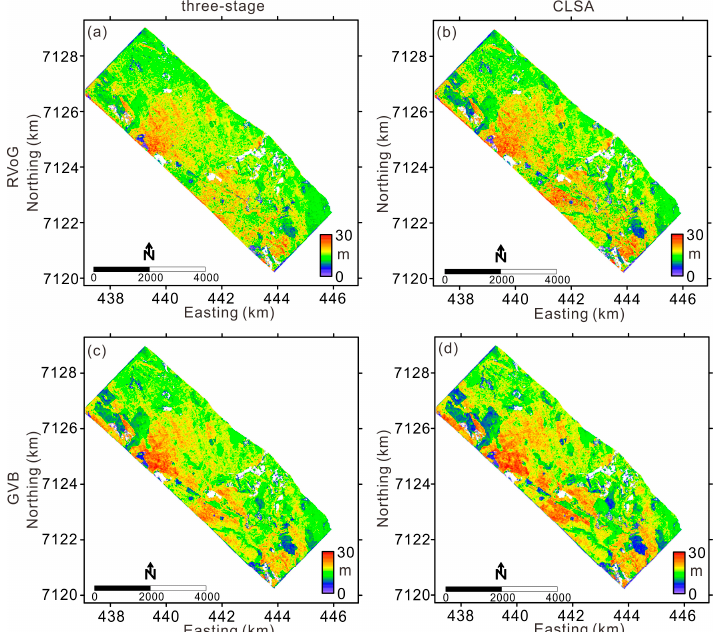
Figure 8. Forest heights inverted by: three-stage and WCLSA with: random volume over ground (RVoG) model ( a , b ); and GVB model ( c , d ).